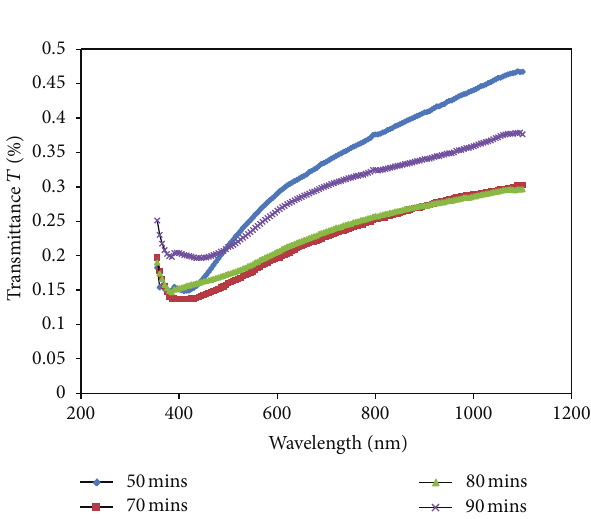
Figure 7: Reflectance versus wavelength.